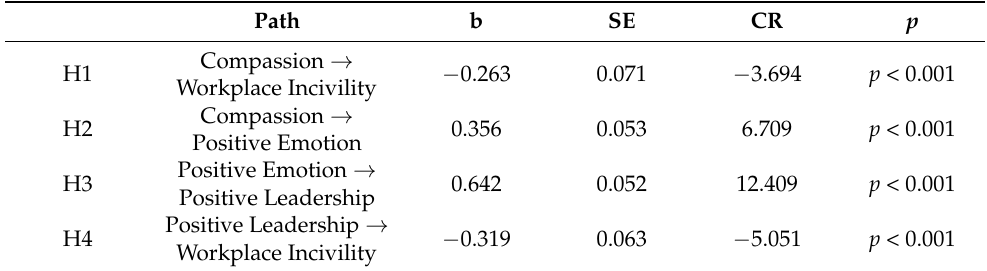
Table 2. Path analysis results.